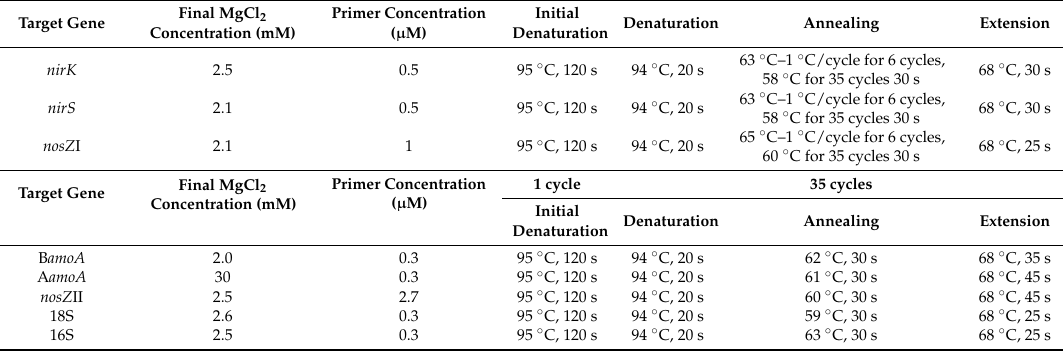
Table A2. QPCR conditions for the different target genes; B amoA standards were generated